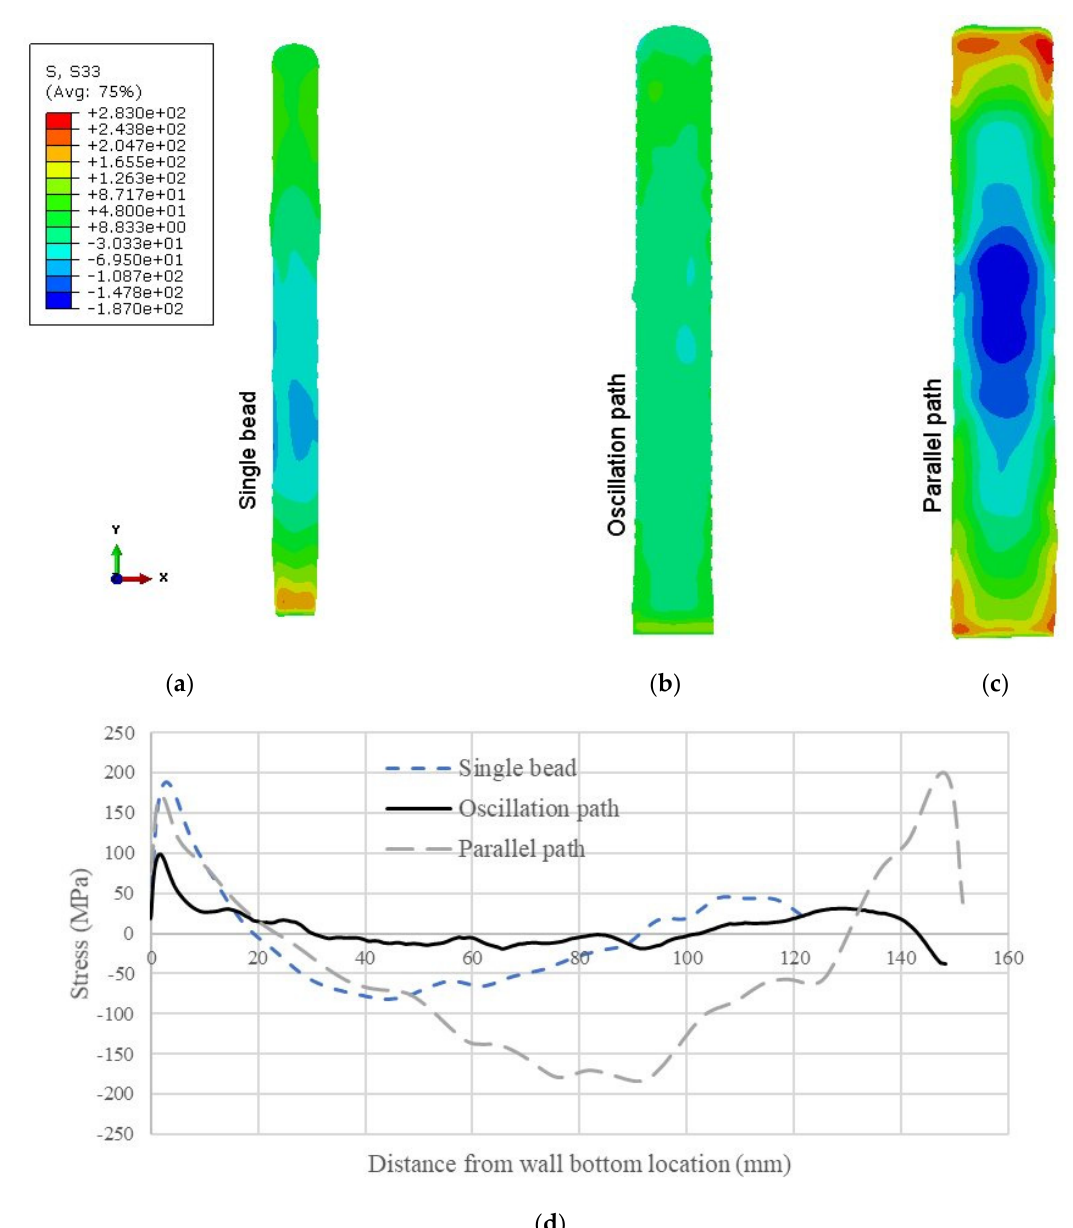
Figure 6. Residual stresses in the single bead (10 mm × 123 mm), parallel path (20 mm × 150 mm) and oscillation path (25 mm × 152 mm) walls: ( a – c ) stress maps, ( d ) stress profiles (value at the mid-thickness) .